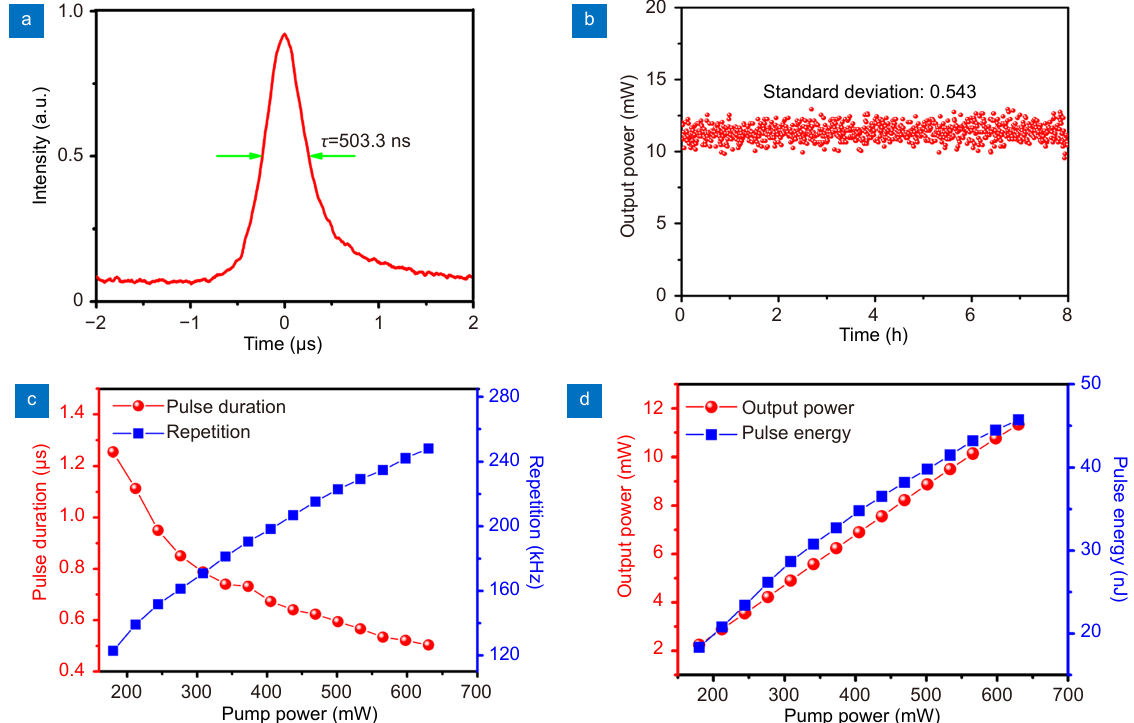
Fig. 5 | The performance of the QSFL based on 4 nm-SnS 2 SA. ( a ) The τ of a single pulse. ( b ) The monitoring of P out within 8 hours. ( c ) Vari- ation of τ and F rep as functions of P pump . ( d ) Variation of P out and E p as functions of P pump